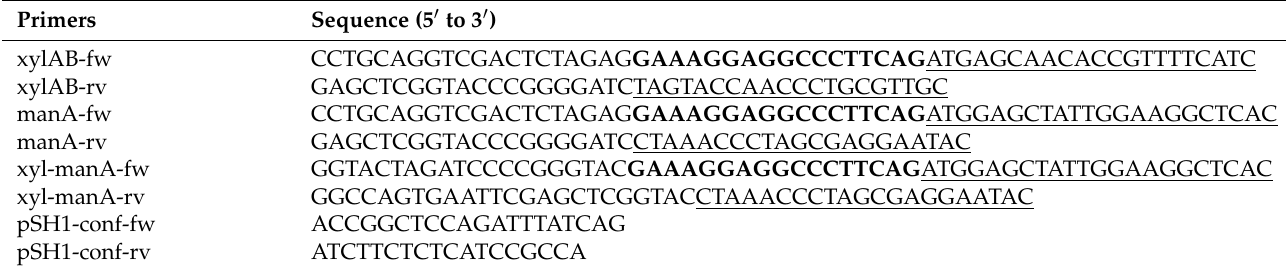
Table 2. Primers used in this study. Ribosomal binding sites are in bold, binding sequences for amplification are underlined.